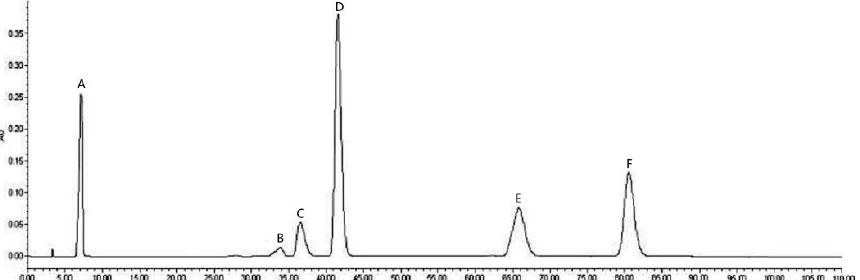
Figure 1. HPLC chromatogram of purified longan pericarp extract (LPE) at 280 nm.